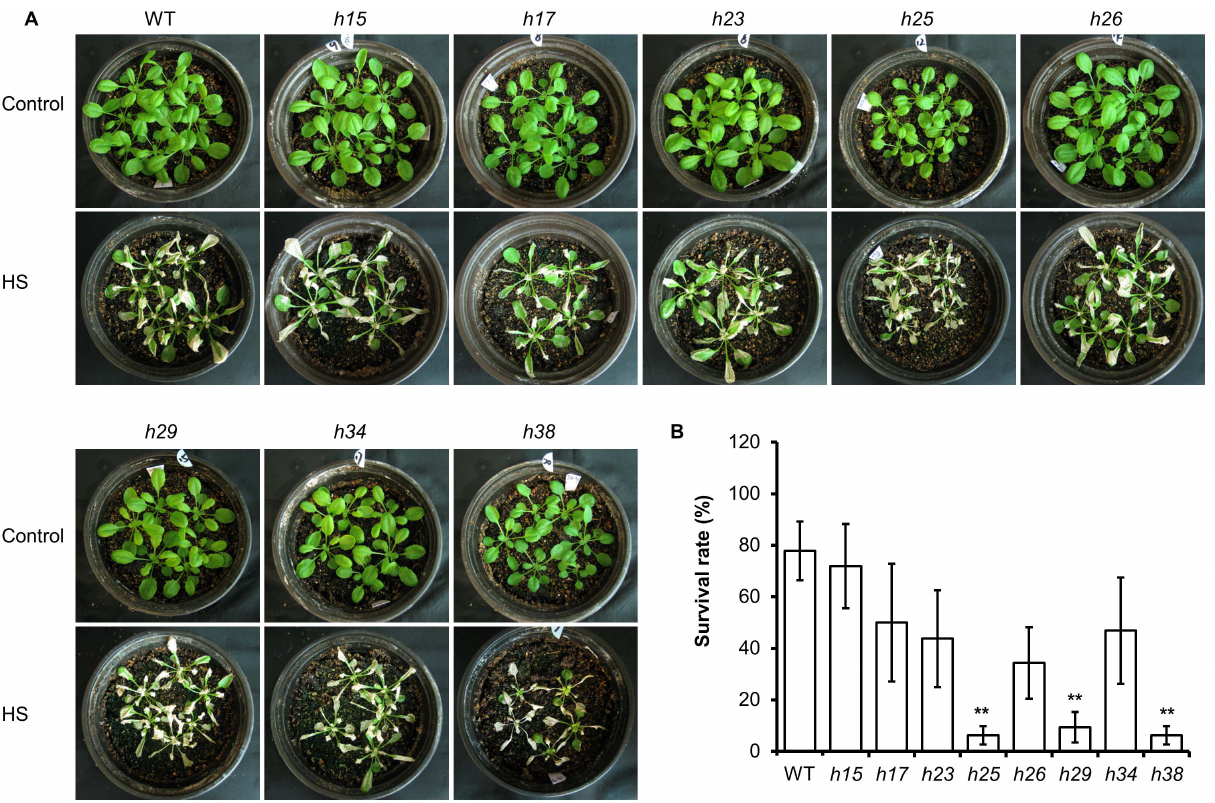
Figure 9. Heat stress tolerance of soil-based plants during continuous heat treatment. (A) Plants under control and heat stress (HS) conditions are shown in parallel. (B) Survival rates of mutant lines after continuous heat treatment. Data were collected at 3 weeks after heat stress in A from three independent replicates. ** indicates a significant difference compared with WT plants for P , 0.01 based on a t-test.